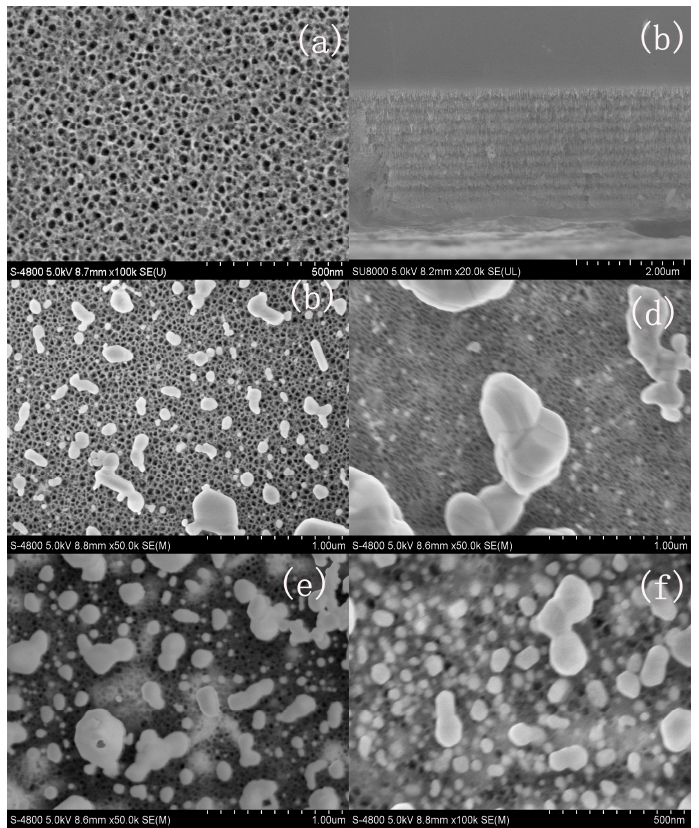
Figure 1. Scanning electron microscope (SEM) images of PS PC substrates ( a ) top view of porous silicon; ( b ) cross-section view of porous silicon; ( c – f ) surface topographies of silver nanoparticles (AgNP)-decorated porous Si with immersing times of 30, 45, 60, and 75 s, respectively.